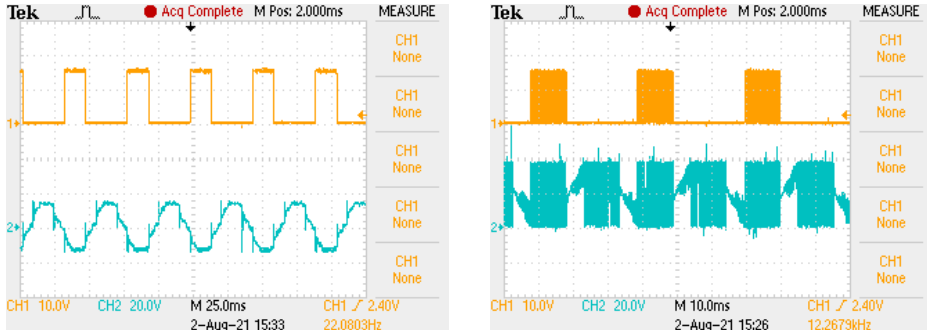
Figure 3. Oscillograms showing the control signal of the bridge transistor ( left ) and the output voltage of the transistor for BLDC motor control with and without PWM ( right ).